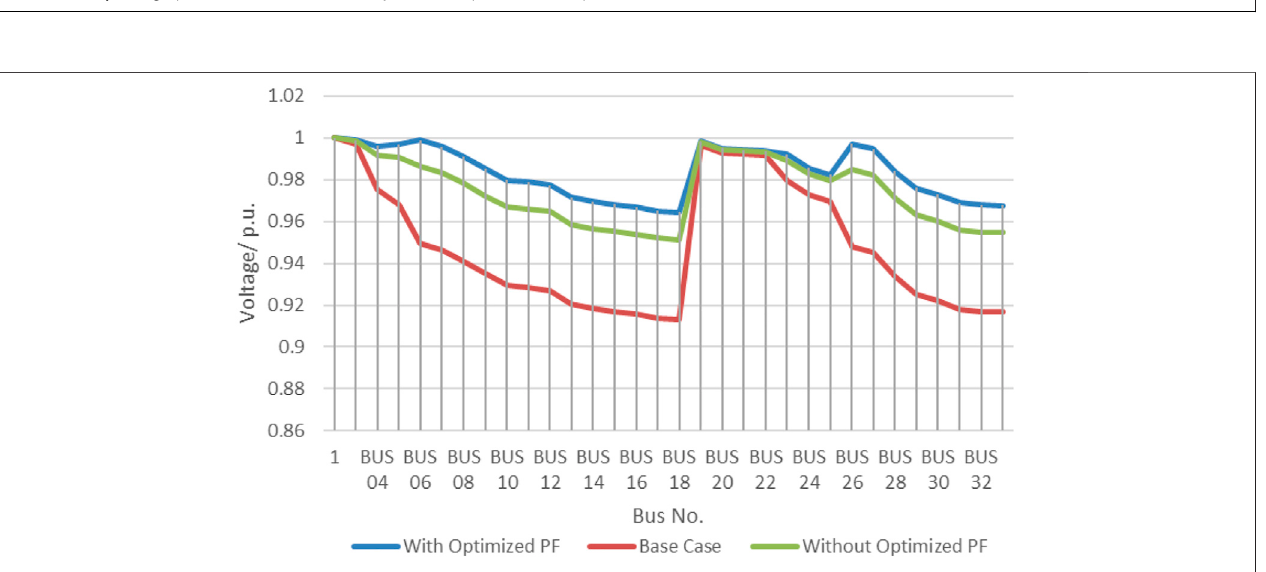
FIGURE 11 | Voltage pro fi le of the IEEE 14 bus system after power factor optimization of PV.